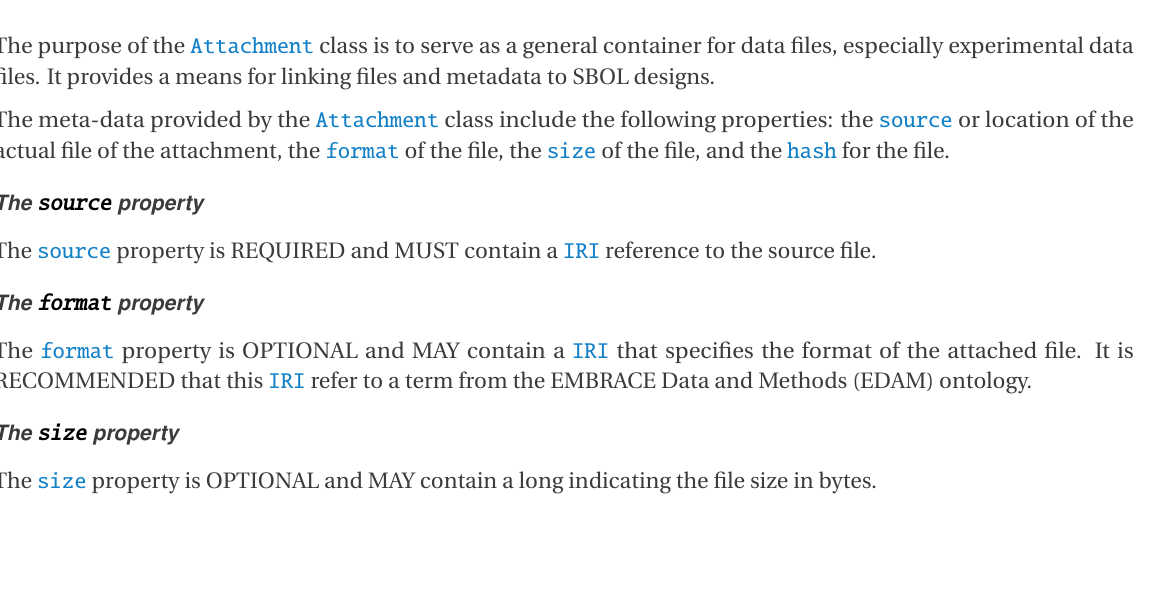
Figure 21: Diagram of the Attachment class and its associated